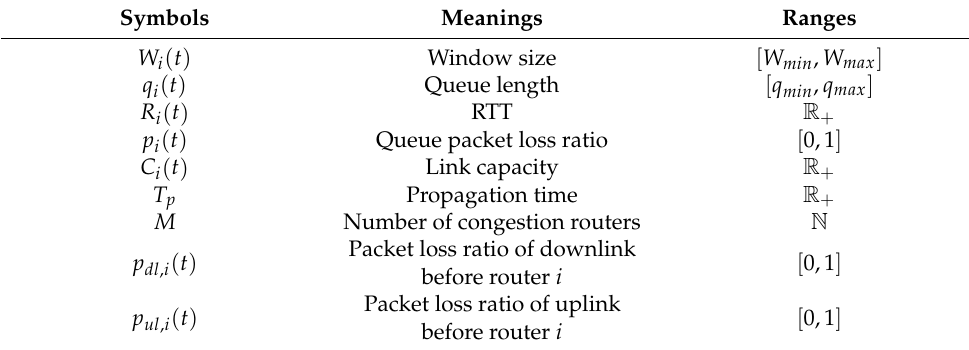
Table 1. Meanings and ranges of